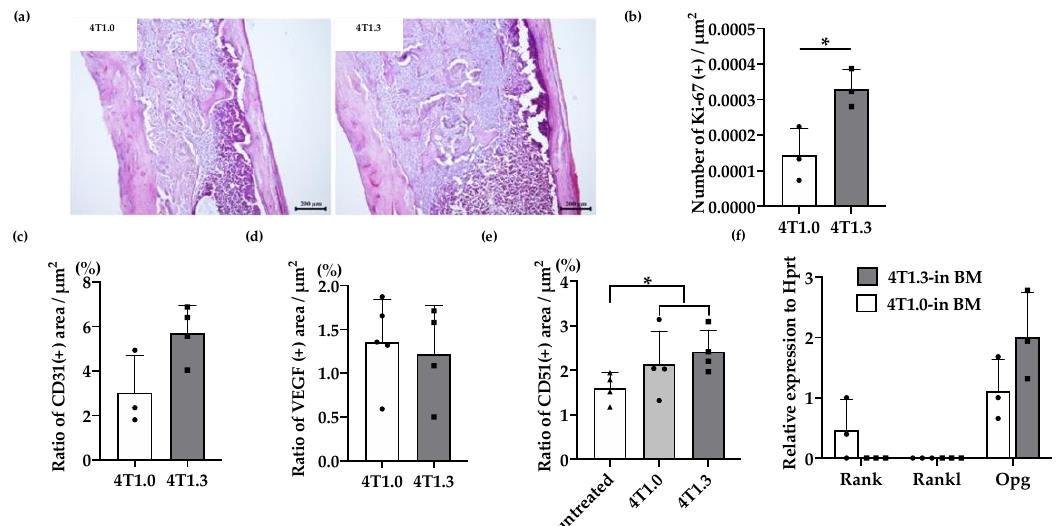
Figure 1. ( a ) H&E staining of 4T1.0 or 4T1.3 tumor foci in a bone cavity. Tibiae were obtained from mice 7 days after intraosseous injection of 4T1.0 or 4T1.3 cells for H&E staining. Representative images from 5 independent mice are shown here. Scar bars, 200 µ m. ( b ) Enhanced cell proliferation at intraosseous tumor sites. Tibiae were obtained from mice 7 days after intraosseous injection of 4T1.0 or 4T1.3 cells and were subjected to anti-Ki67-antibody staining. All values represent mean + SD ( n = 3). * p < 0.05. ( c , d ) Quantitative analysis of CD31- and VEGF-positive areas in 4T1.0 or 4T1.3 tumor foci in a bone cavity. Tibiae were obtained from mice 7 days after intraosseous injection of 4T1.0 or 4T1.3 cells and were subjected to anti-CD31 ( c ) or anti-VEGF ( d ) antibody staining. All values represent mean + SD ( n = 3 to 5). ( e ) Quantitative analysis of CD51-positive areas in tumor-bearing bones. Tibiae were obtained from mice untreated or 7 days after intraosseous injection of 4T1.0 or 4T1.3 cells and were subjected to anti-CD51 antibody staining. All values represent mean + SD ( n = 4). * p < 0.05. ( f ) Determination of intraosseous mRNA expression level of Rank , Rankl , and Opg in 4T1.0- or 4T1.3-injected mice. Total RNAs were extracted either from 4T1.0 or 4T1.3 cells isolated from a bone marrow cavity at day 7 after intraosseous injection. All values represent mean + SD ( n = 3).